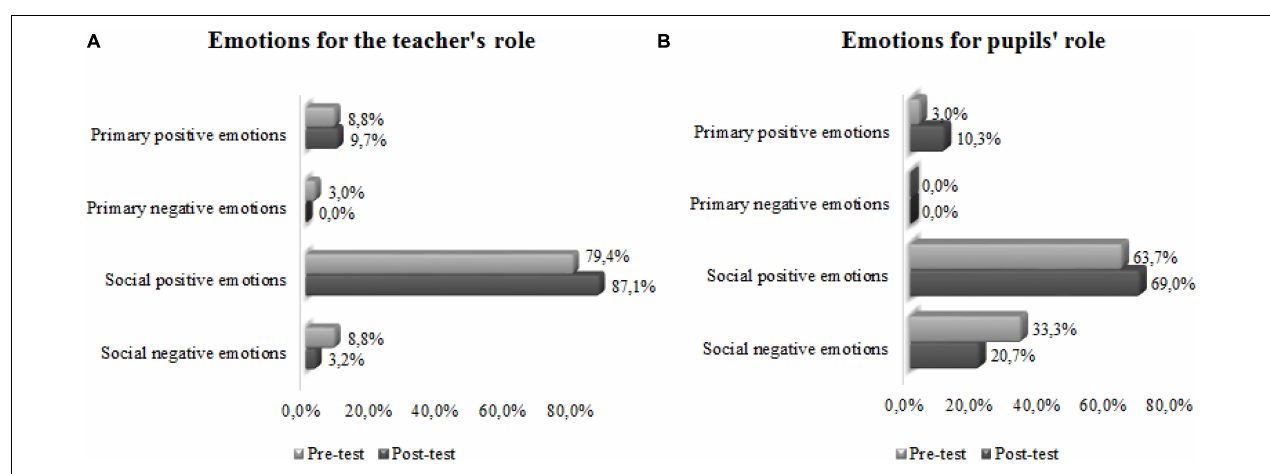
CHART 3 | (A,B) Comparison of the percentages of emotions for the teacher’s and the pupils’ roles, before and after the practicum.